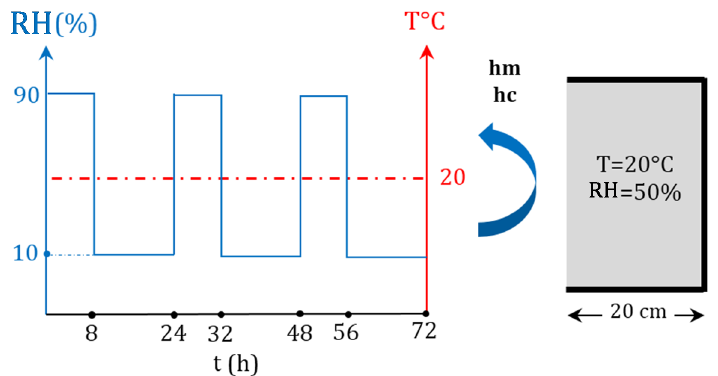
Figure 6. Schematic diagram showing the climatic conditions applied in the isothermal case.